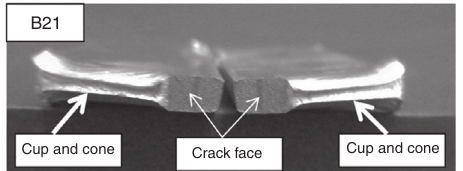
Figure 12 Typical meshed model of the cracked plate and the sin- gularity near the crack